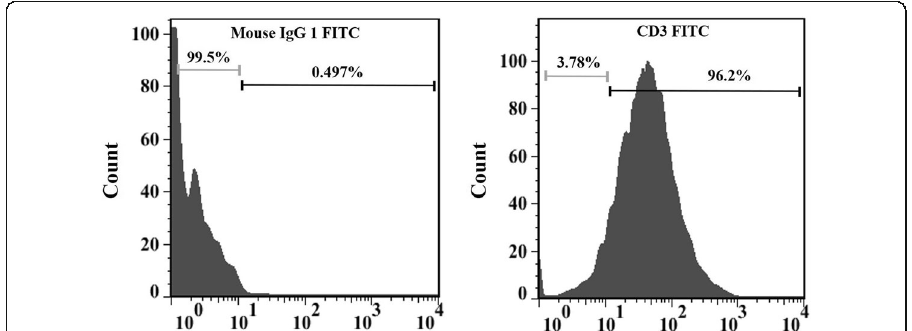
Fig. 2 The purity of CD3 + primary T cells isolated from PBMCs using MACS. The isolated cells were stained with anti-CD3 conjugated to FITC and isotype control antibody and analyzed via flow cytometry. The histograms show the isotype-controlled cells (left) and anti-CD3 stained T cells (right) of the enriched fraction. Results are representative of three independent experiments